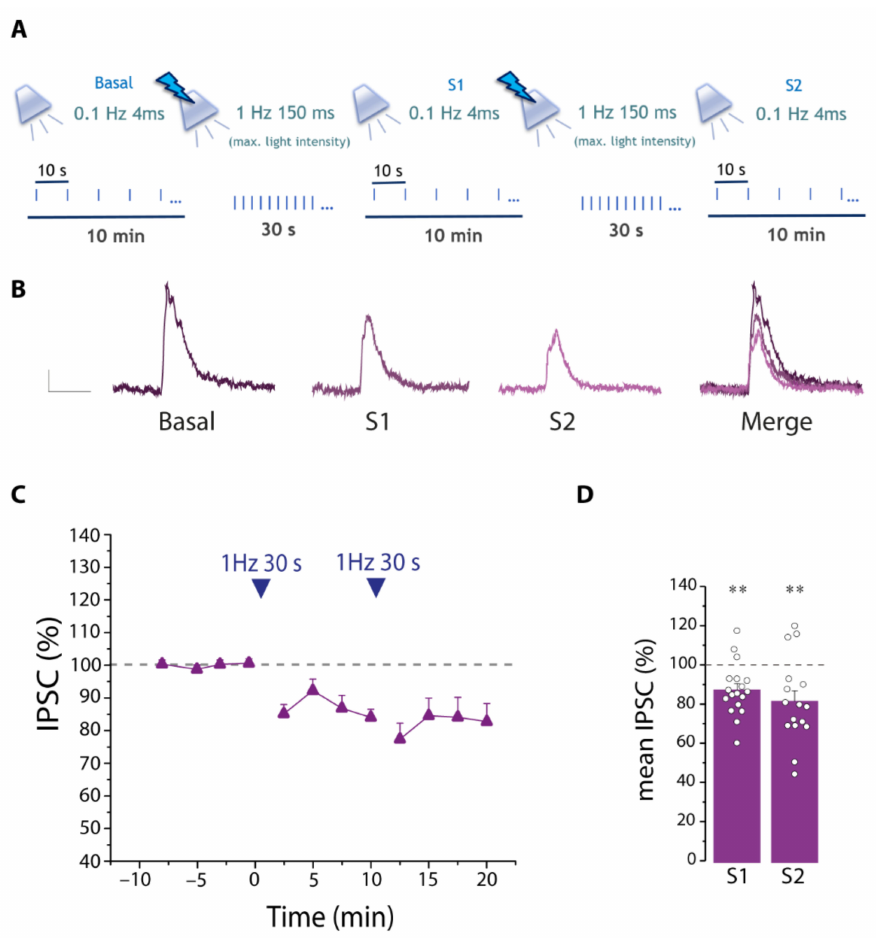
Figure 7. Intense stimulation of SST interneurons decreases the amplitude of inhibitory currents on PNs. ( A ) Schematic of the protocol for IPSC recordings in PNs and stimulation of SST interneurons. ( B ) Representative evoked IPSCs before (basal) and after the first (S1) and the second (S2) 30 light pulses and merger of all IPSCs. Scale bar, 50 ms, 10 pA. ( C ) Time course of the mean normalized IPSC amplitude before and after the 30 light pulse stimulations ( n = 18). In this figure and the other figures reporting IPSCs amplitude vs time, t = 0 indicates the end of the first 30 pulse stimulation. ( D ) Quantification of the mean normalized IPSC amplitude during 10 min after the first (S1) and second (S2) stimulation. Note that an intense stimulation of SST interneurons disinhibits PNs. * statistical comparison with basal conditions, ** p < 0.01, paired t -test.